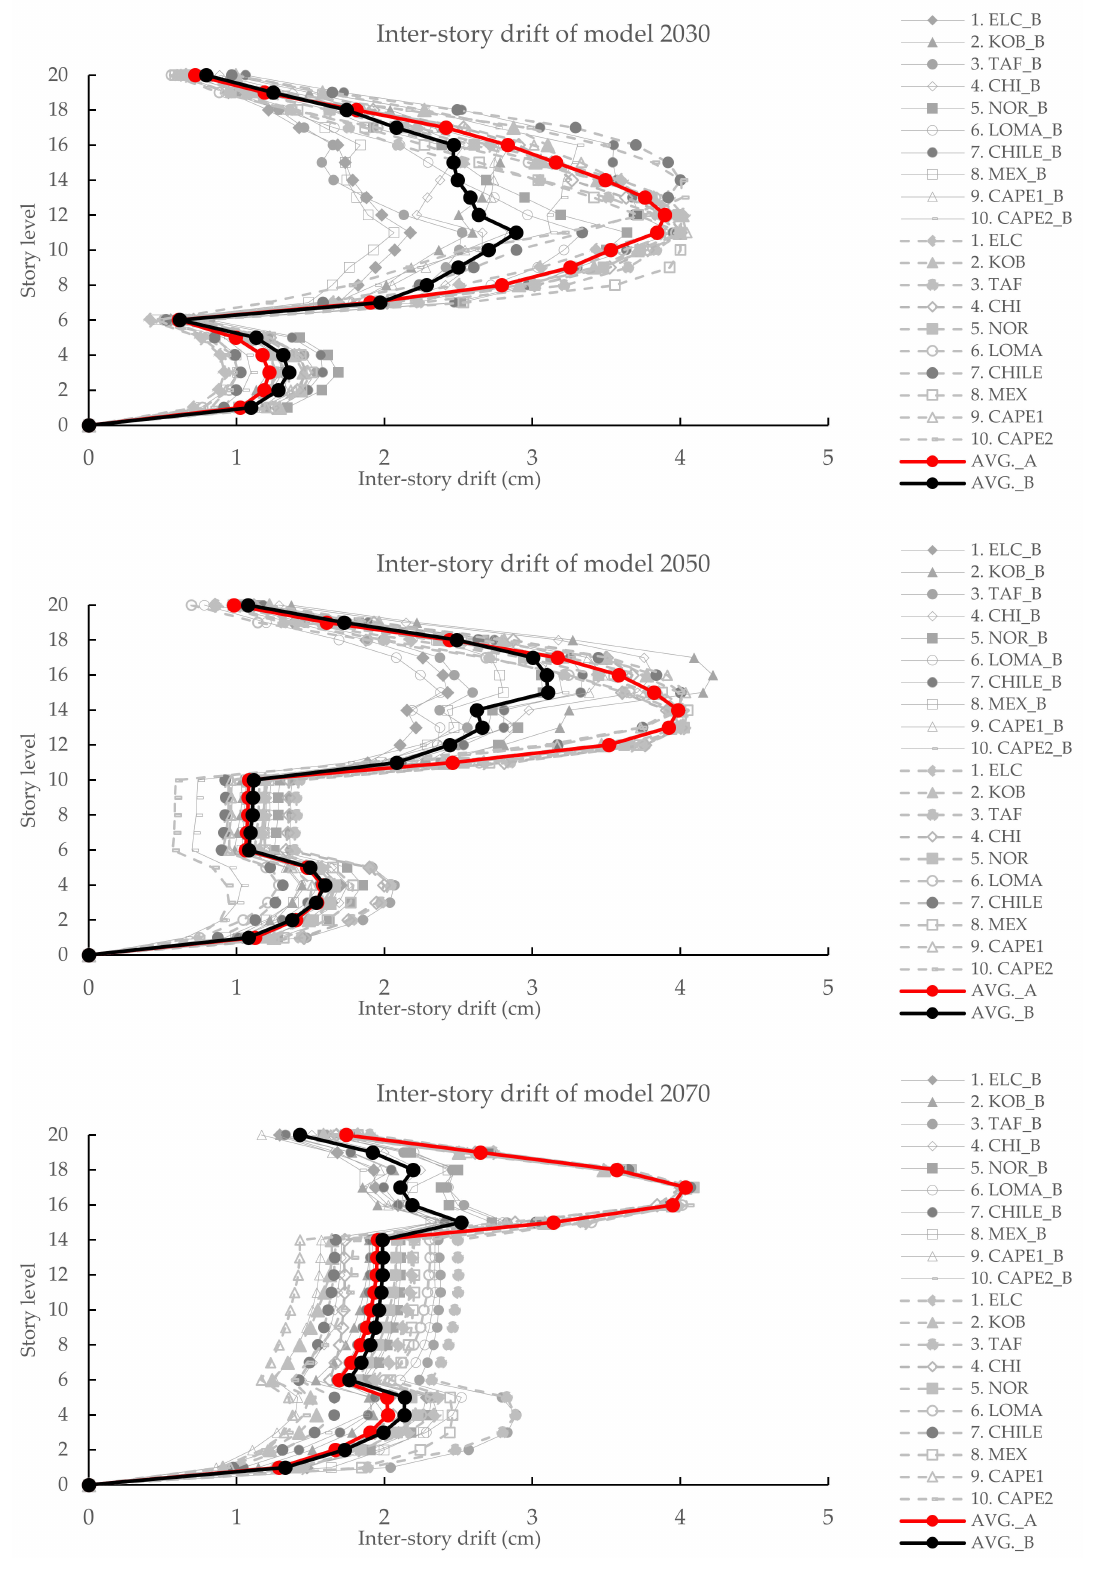
Figure 23. Comparison of inter-story drift distribution of frame-curtailed wall structure without BRBs and with BRBs for 20